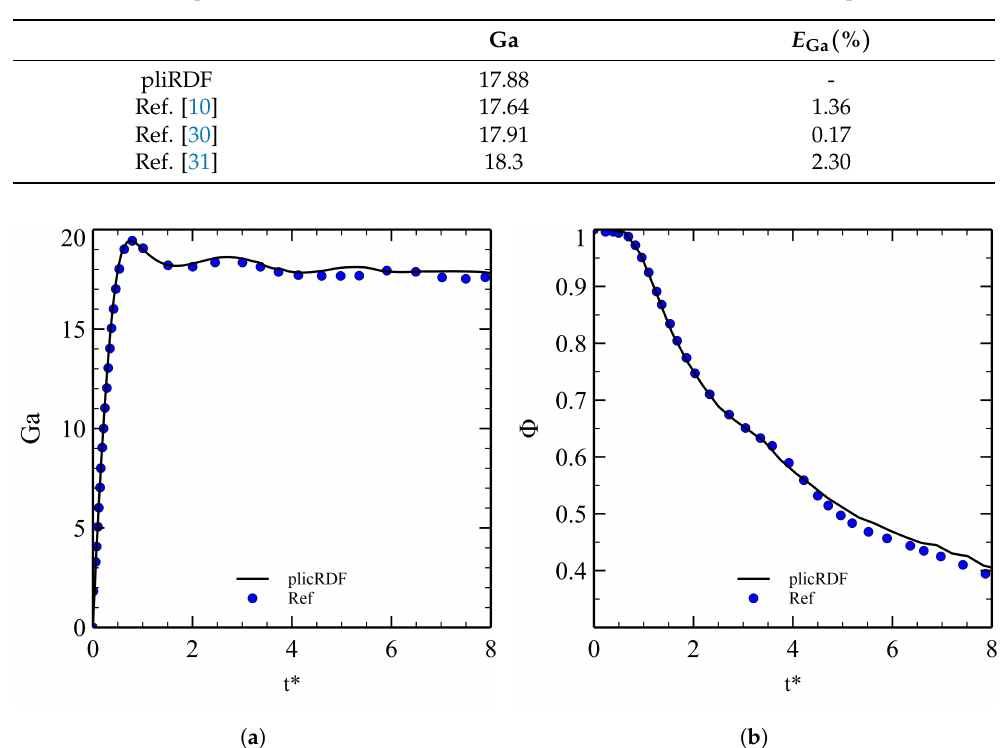
Table 11. Benchmark results for the 3D C2 case (M4 mesh) compared against numerical data from